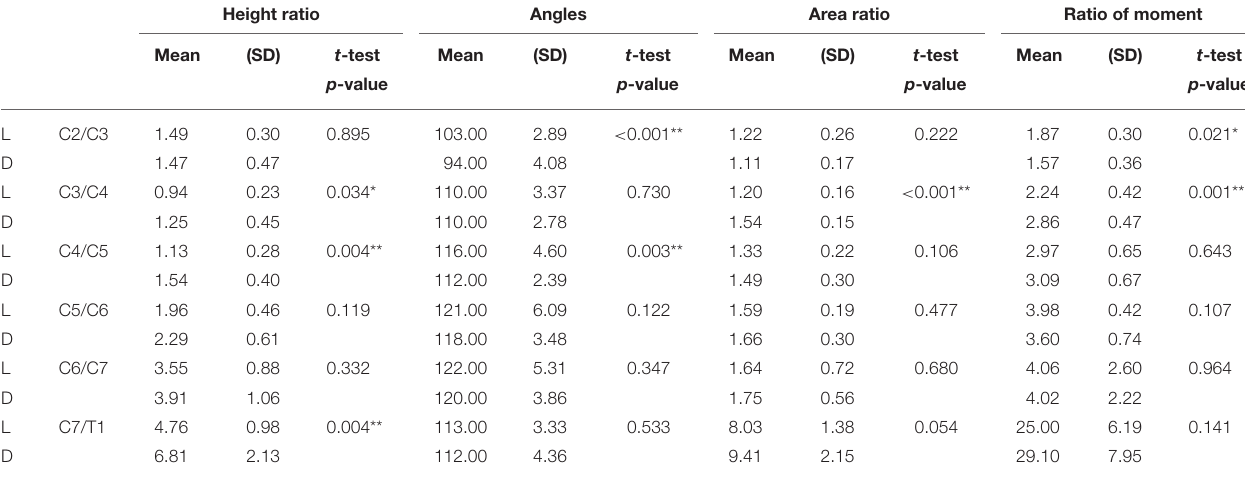
Also shown are t-test p-values comparing CD and NCD dogs at each cervical vertebral location. P–values α < 0.05 were considered statistically significant and are flagged with a * . Although the analysis is exploratory, multiple comparisons are considered using a Bonferroni adjusted α < 0.0083 with a flag of **